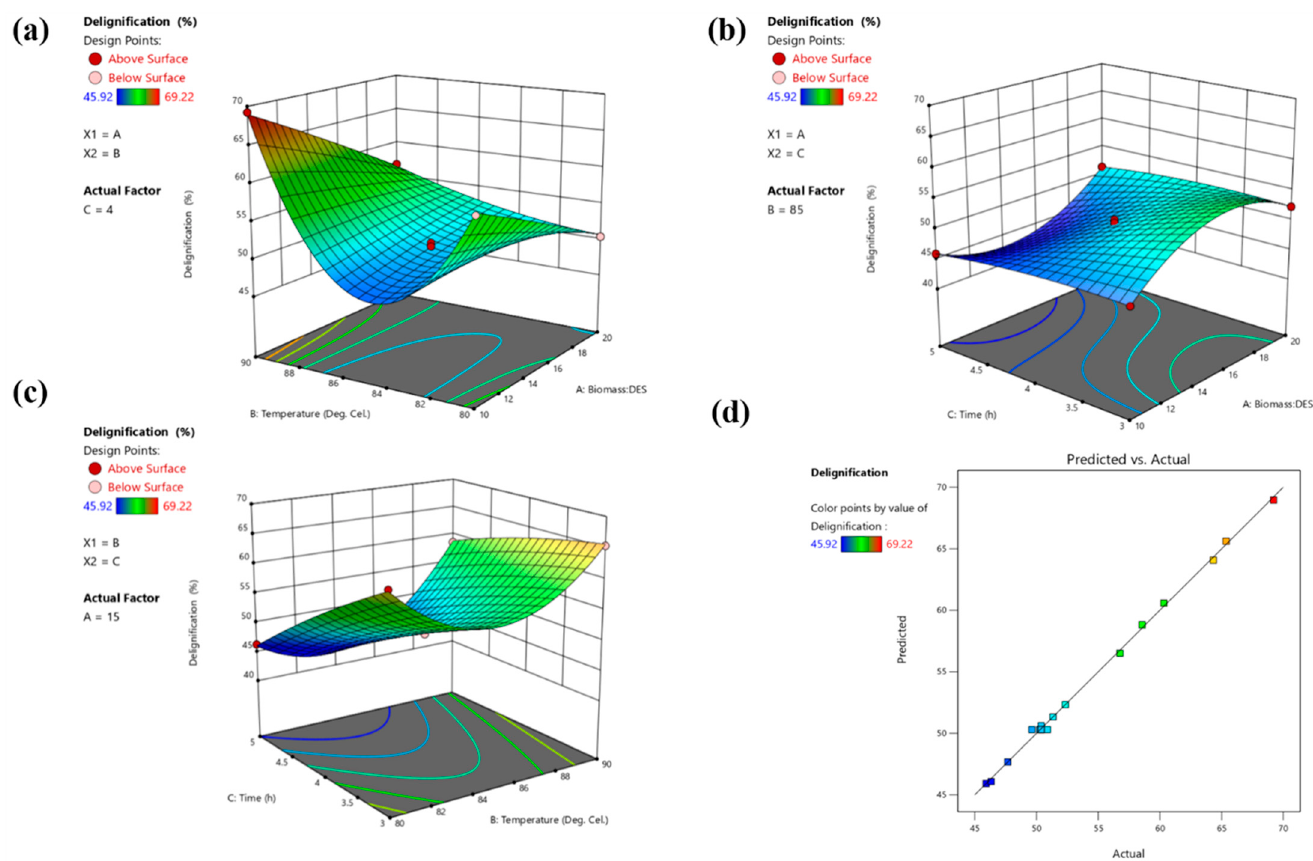
Figure 2. Three-dimensional surface plots representing the interactive effects of ( a ) biomass:DES vs. temperature; ( b ) biomass:DES vs. time; and ( c ) time vs. temperature on WH delignification. ( d ) Interactive plot of observed and theoretical WH delignification from BBD-RSM-based optimization.